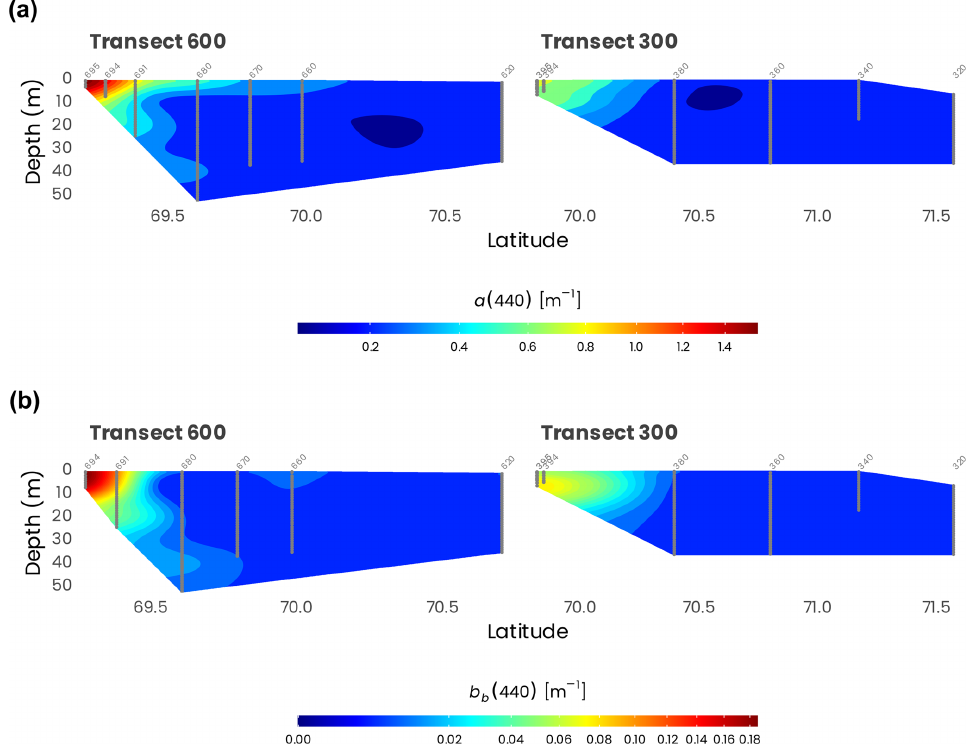
Figure 6. Cross-sections of (a) absorption ( a (440)) and (b) total scattering ( b b (440)) measured from the barge at 440nm with an AC9 and BB9, respectively, along transects 600 and 300. Station numbers are identified in light gray on top of each panel. Note that the data have been square-root-transformed for the